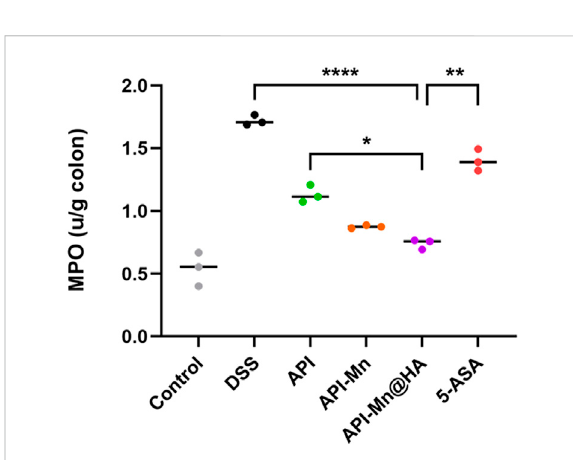
FIGURE 6 Histogram of the activity of MPO, a marker of the activation and function of neutrophils. Data are shown as mean ± SD. n = 5, * p < 0.05, ** p < 0.01, *** p < 0.001 and **** p <